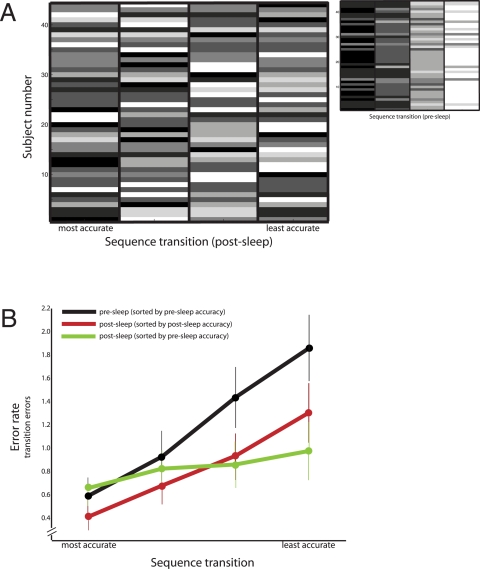
Accuracy (error rate) as a function of transition.A) Post-sleep error rate order, as depicted in shades of gray, across the four transitions of the motor sequence arranged according to pre-sleep order (abscissa) for all forty-four subjects (ordinate). For instance, a white cell in the leftmost column of a row means the corresponding subject had the smallest error rate (highest accuracy) prior to sleep on the particular transition among four but the largest error rate following sleep. Ties, which correspond to multiple transitions sharing the same error rate, are shown in intermediate shades of gray. Inset shows pre-sleep error rates on individual transitions sorted by pre-sleep order. B) Error rates (number of errors / 30 sec trial) on the within-sequence transitions are shown. The transitions were ordered according to increasing error rate (decreasing accuracy) for each subject separately and later combined to yield a group mean and s.e.m., which is shown for pre-sleep (black) and post-sleep trials (red and green). For each subject, the post-sleep transitions were ordered by increasing pre-sleep error rate (green) or by increasing post-sleep error rate (red). In the case where the transitions were sorted by the respective degrees of accuracy, post-sleep error rates (red) were no more uniform statistically than pre-sleep error rates (black).